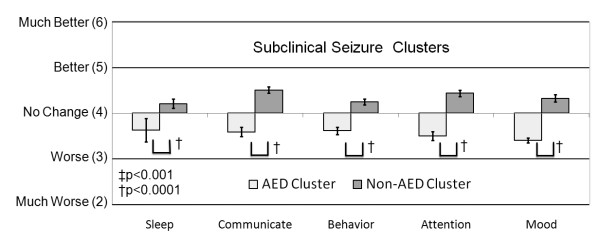
Treatments for subclinical seizures cluster into anti-epileptic drug and non-anti-epileptic drug treatments. In general, anti-epileptic drug treatments were perceived as worsening clinical factors while non-anti-epileptic drug treatments appeared to improve clinical factors.